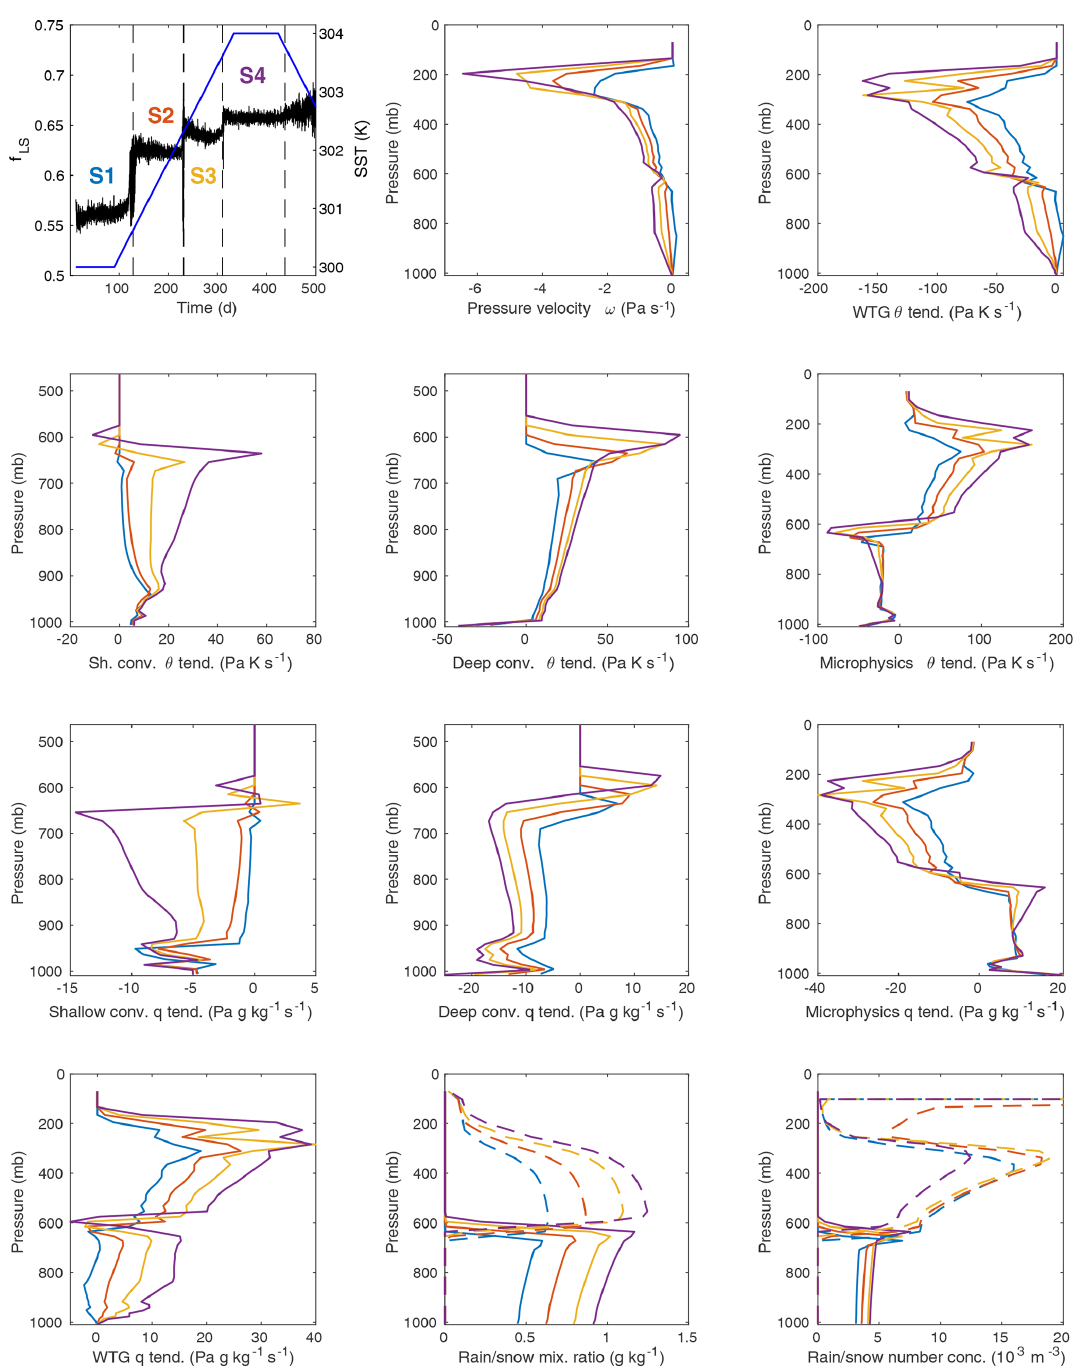
Figure 5. Four quasi-stationary states of the heating WRF SCM with WTG approximation. For the top left plot, the left axis shows f LS for the WRF SCM over the first 500d of an 800d integration with the WTG approximation active and a background profile calibrated for 300K SST. Four quasi-stationary states (S1, S2, etc.) are indicated. The right axis shows SST over the same integration. The remaining plots show vertical profiles for the labeled quantities, averaged over time for each of the four states (S1 blue, S2 red, S3 yellow, S4 purple). The four plots showing convective forcing profiles stop near 500mb because they are zero above. WRF model forcings are mass-weighted, hence the units in terms of pressure. In the last two plots for rain or snow mixing ratio and number concentration, the solid lines represent rain and the dashed lines represent snow. See also Table